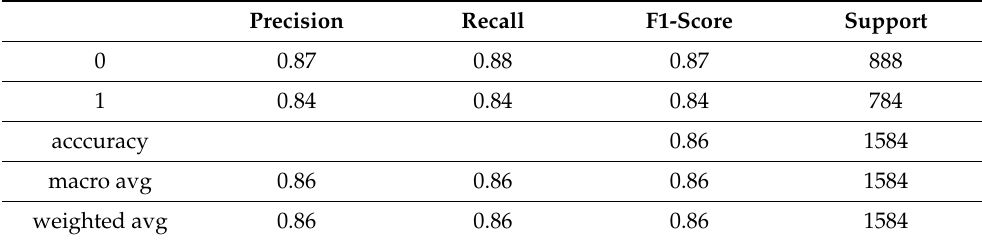
Table 2. Random Forest model performance.